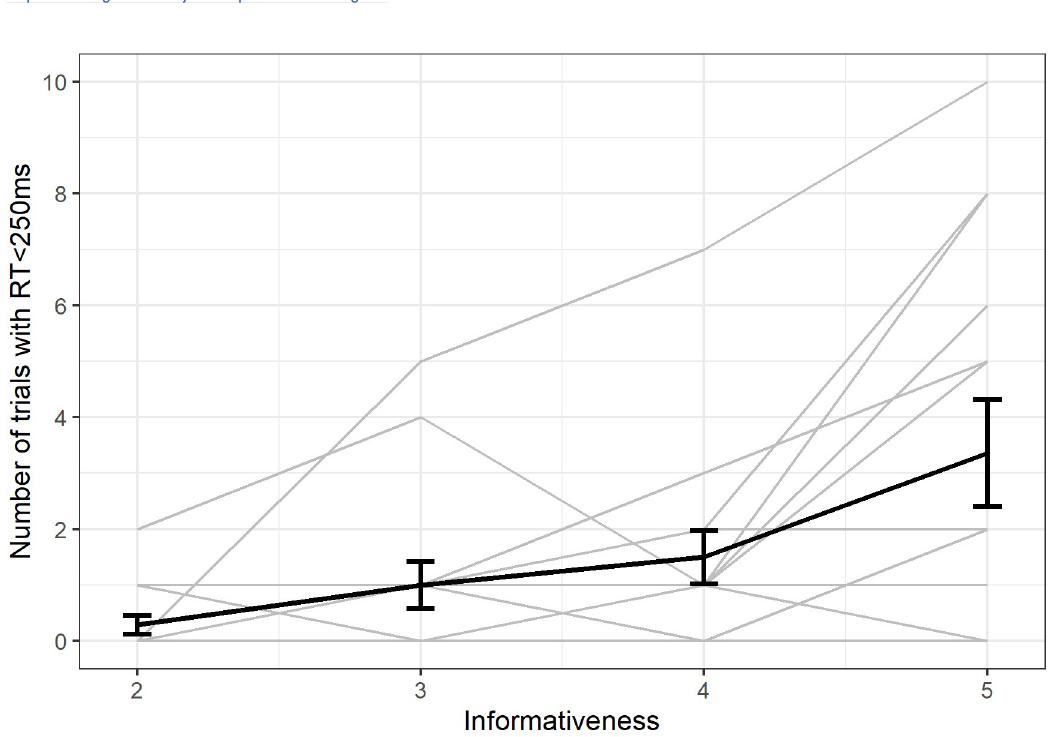
Fig 11. Increase in the number of correct revealed trials with RT < 250ms. Individual responses (light grey) with group average (error bars represent standard error).